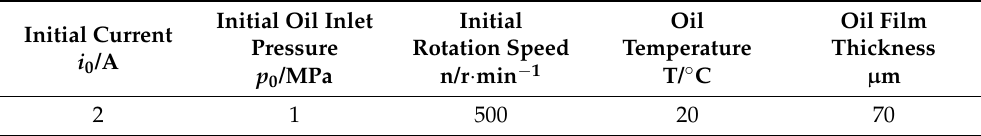
Table 1. Initial working parameters of magneto-liquid bearing.